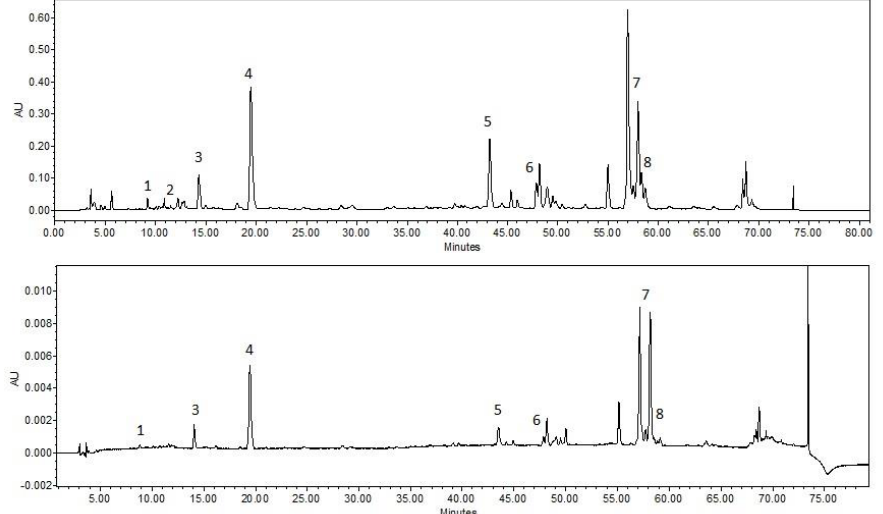
Figure 1. HPLC analysis of the chemical composition of of 30% aqueous PEG400 balsam poplar buds extract and BC12 gel with balsam poplar buds extract. Above — chromatogram of 30% aqueous PEG400 balsam poplar buds extract after sterilization, Below — chromatogram of BC12 gel after sterilization. 1. salicin, 2. chlorogenic acid, 3. caffeic acid, 4. P -coumaric acid, 5. cinnamic acid, 6. pinobanksin, 7. pinocembrin, 8. galangin. The chromatogram is presented at a wavelength of 290 nm.